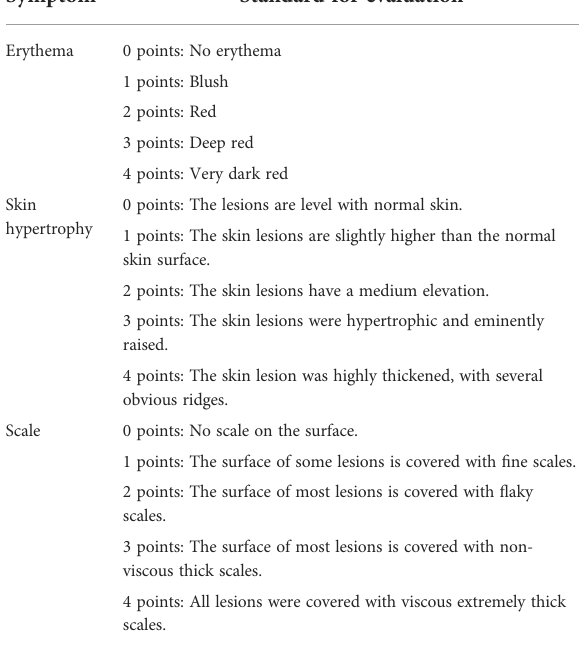
TABLE 1 PASI scoring